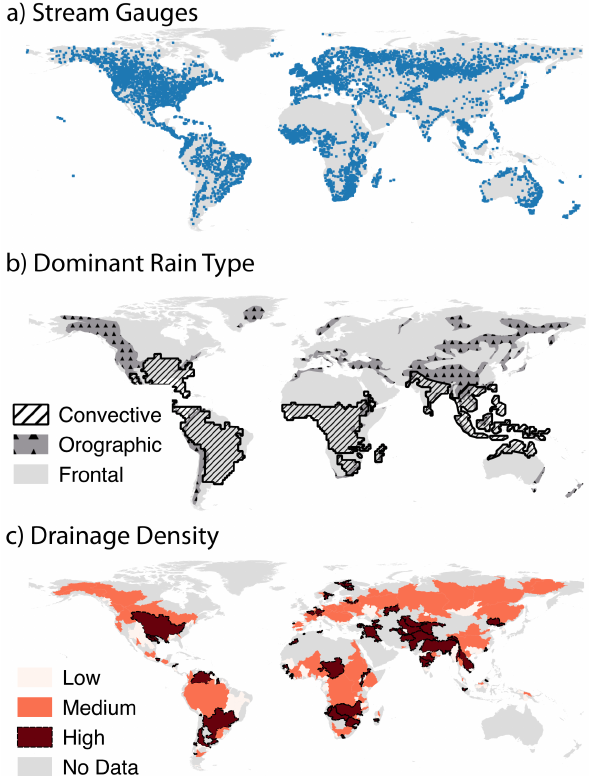
Figure 7. Global distribution of factors affecting model selection. (a) Spatial repartition of the 8540 stream gauges indexed by the Global Runoff Data Center (Global Runoff Data Center, 2014). (b) Dominant rainfall type: orographic rainfall are assumed to oc-